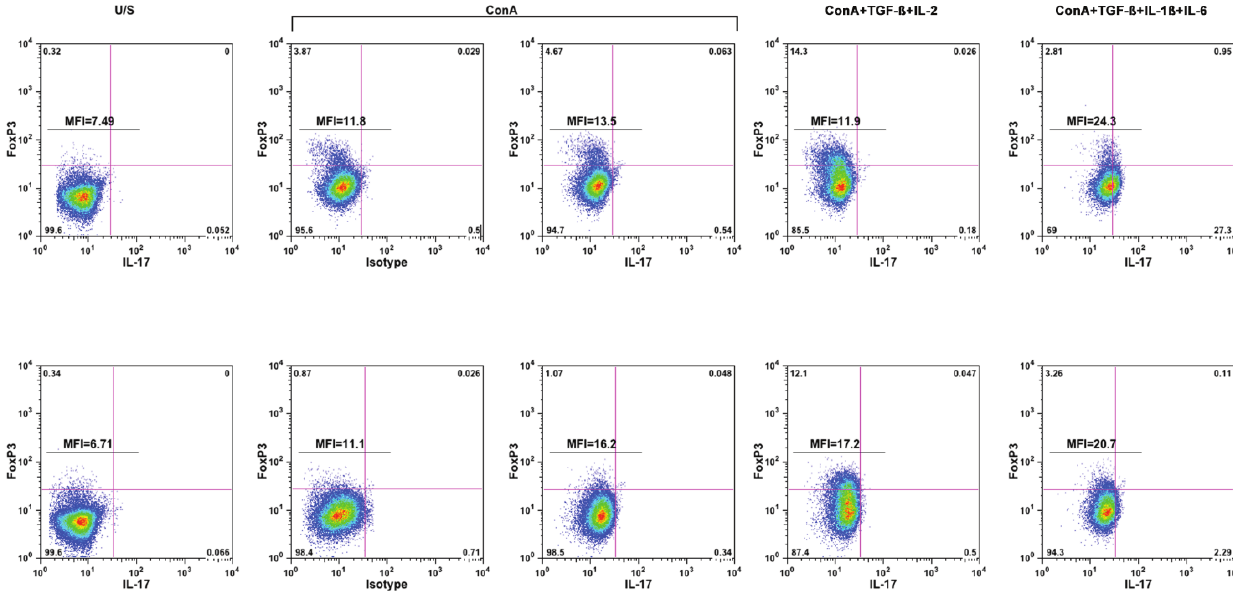
Figure 2. Addition of TGF-(cid:2), IL-1(cid:2), and IL-6 increases polarization of CD4 + cells toward the Th17 phenotype. PBMCs from two dogs were stimulated as described in the main text and analyzed for polarization of T helper (CD4 + ) cells toward FoxP3 + (Treg) and IL-17 + (Th17) phenotypes using flow cytometry. CD4 + cells were identified as described